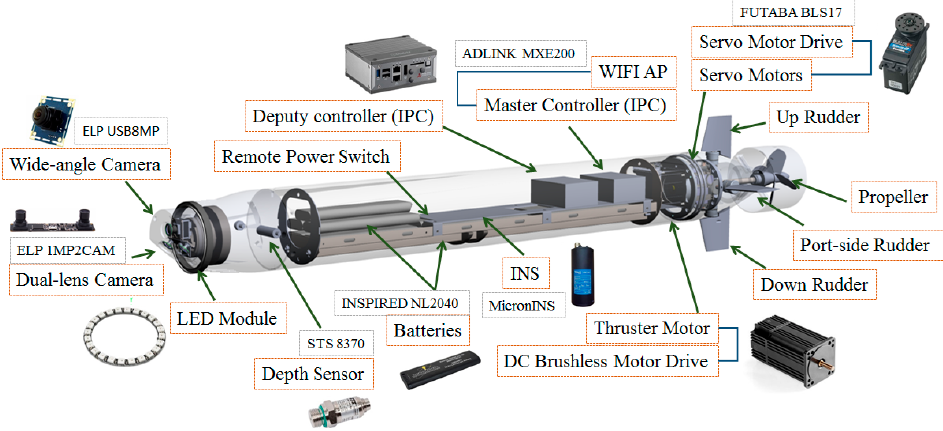
Figure 1. Architecture of the autonomous underwater vehicles (AUV) “Bigeye Barracuda”. Table 1. Specification of Bigeye Barracuda.